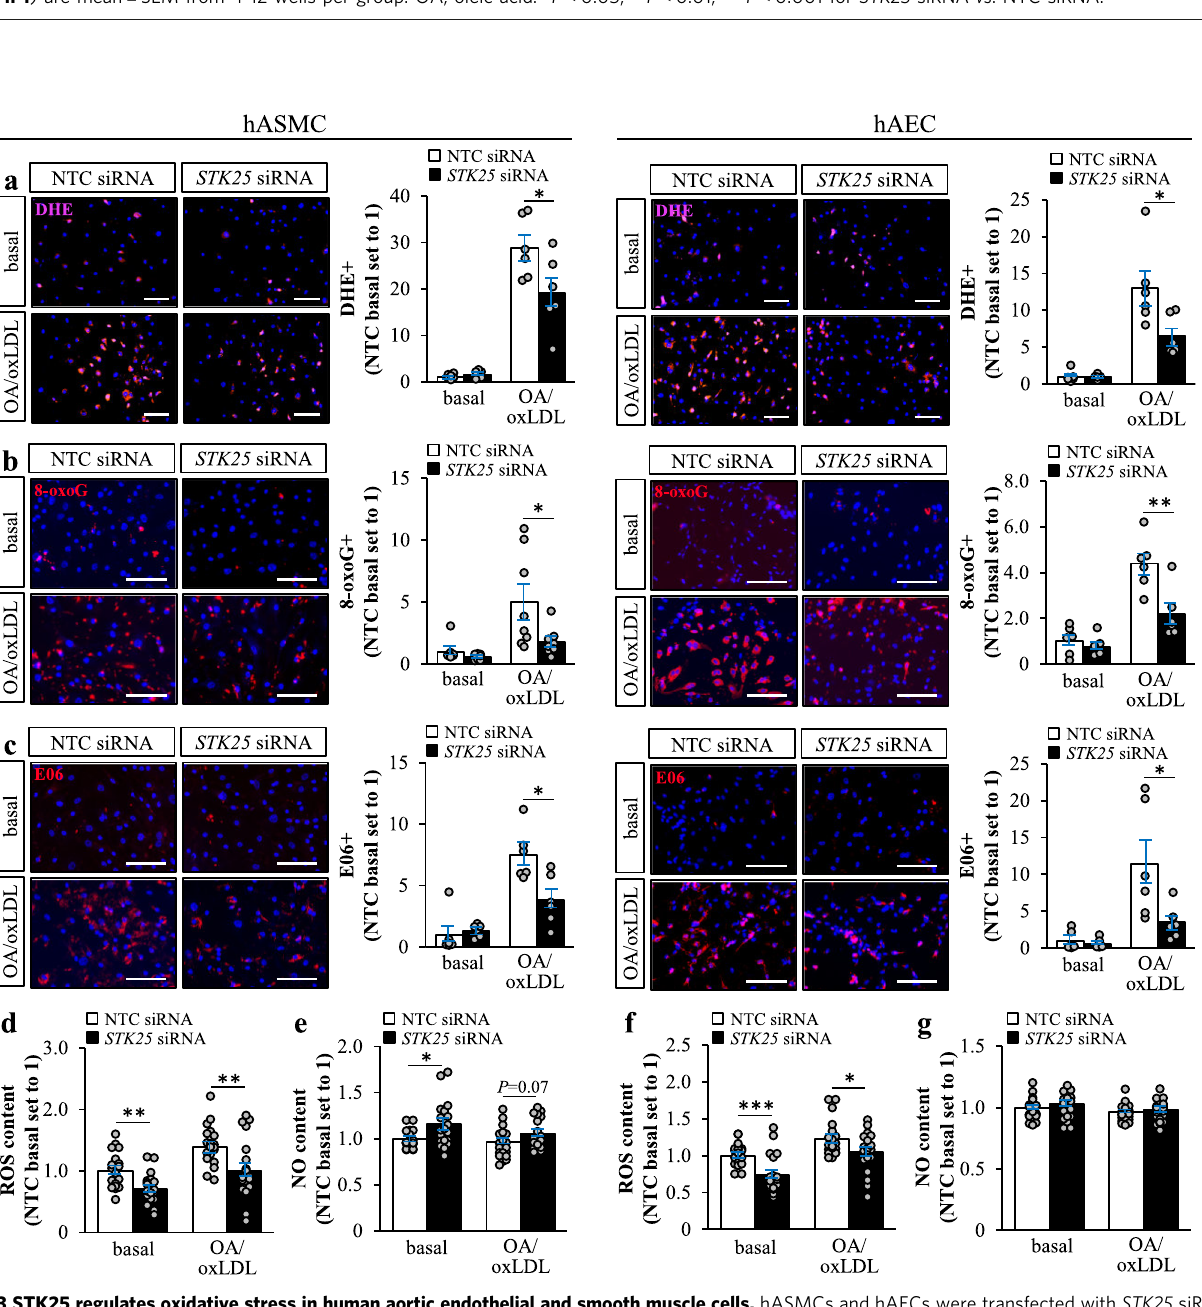
Fig. 2 Knockdown of STK25 suppresses in fl ammation and fi brosis in human aortic endothelial and smooth muscle cells. hASMCs and hAECs were transfected with STK25 siRNA or NTC siRNA. a , g Representative immuno fl uorescence images of cells stained with anti-NF κ B antibody (green); nuclei stained with DAPI (violet); colocalization shown in white. Quanti fi cation of the ratio of nuclear to cytoplasmic staining. b , h Nuclear extracts were analyzed by Western blot using antibody speci fi c for NF κ B. Protein levels were analyzed by densitometry; representative Western blots are shown with lamin B (nuclear marker) and vinculin (cytoplasmic marker) used as controls. Cytoplasmic fraction was analyzed by Western blot using antibody speci fi c for STK25 to demonstrate the transfection ef fi cacy; representative Western blots are shown with vinculin used as a loading control. c , i Concentration of secreted cytokines and chemokines. d , j Representative images of calcein acetoxymethyl-stained THP-1 monocytes (green). Quanti fi cation of the staining. e , k Relative gene expression of selected fi brosis markers 24 h after TGF- β 1 stimulation. f , l Concentration of collagens in media 24 h after TGF- β 1 stimulation. In ( a , g ) and ( d , j ), the scale bars represent 10 and 50 µ m, respectively. Data in ( a , g ) are mean ± SEM from 30 cells per group; data in ( b – f , h – l ) are mean ± SEM from 4-12 wells per group. OA, oleic acid. * P < 0.05, ** P < 0.01, *** P < 0.001 for STK25 siRNA vs . NTC siRNA.